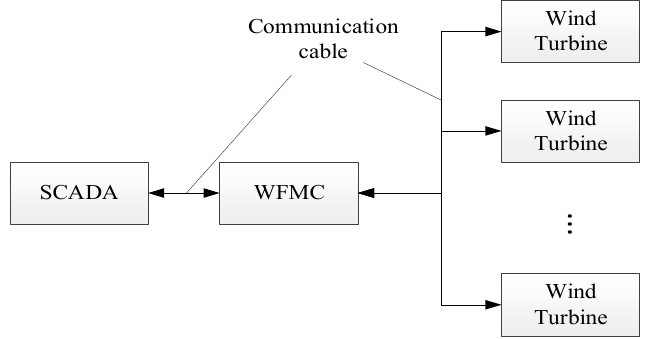
Figure 2. The power control and communication scheme in an OWF.